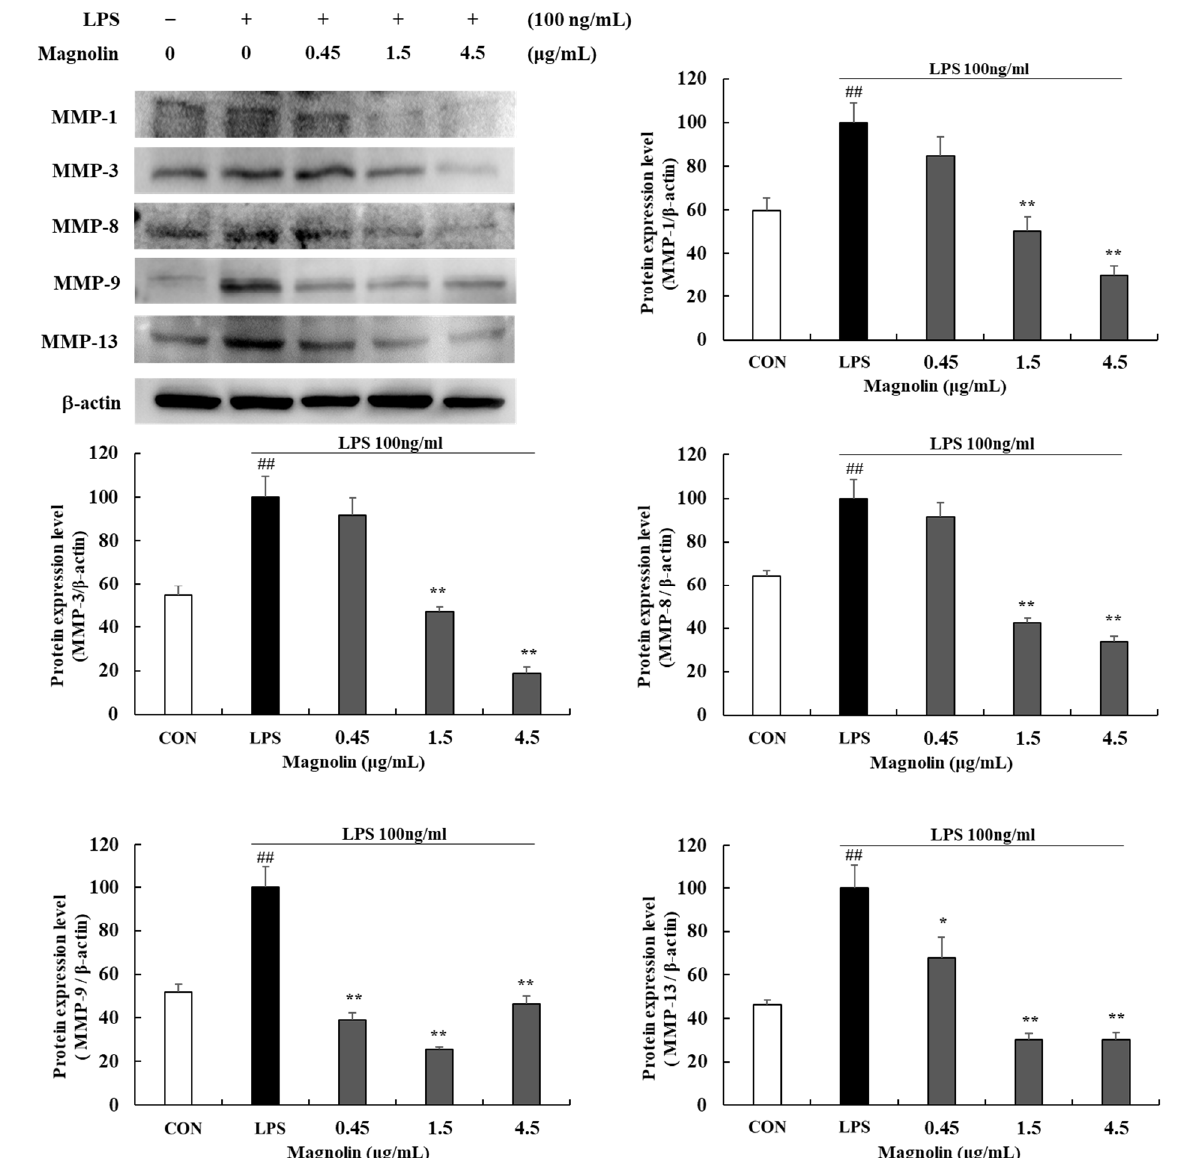
Figure 7. Effects of magnolin (0.45, 1.5, and 4.5 μg/mL) on the production of MMPs in LPS-stimulated RAW 264.7 cells. Magnolin and 100 ng/mL of LPS was added except for in vehicle control group and incubated at 37 °C for 24 h. Protein expression levels of MMP-1, MMP-3, MMP-8, MMP-9 and MMP-13 were detected by Western blot. The protein band density was measured by utilizing ImageJ software. β-actin was used as a control. Values represented means ± standard deviation. ## p < 0.01 vs. Vehicle control group; * p < 0.05 and ** p < 0.01 vs. LPS-activated control group.